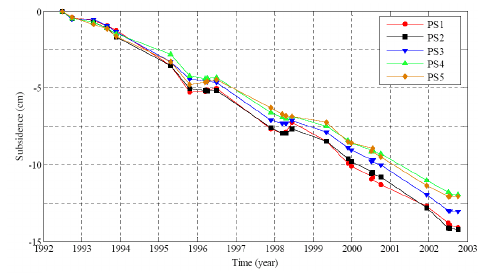
Figure 8. Time series of subsidence at 5 PSs as marked in Figure 5